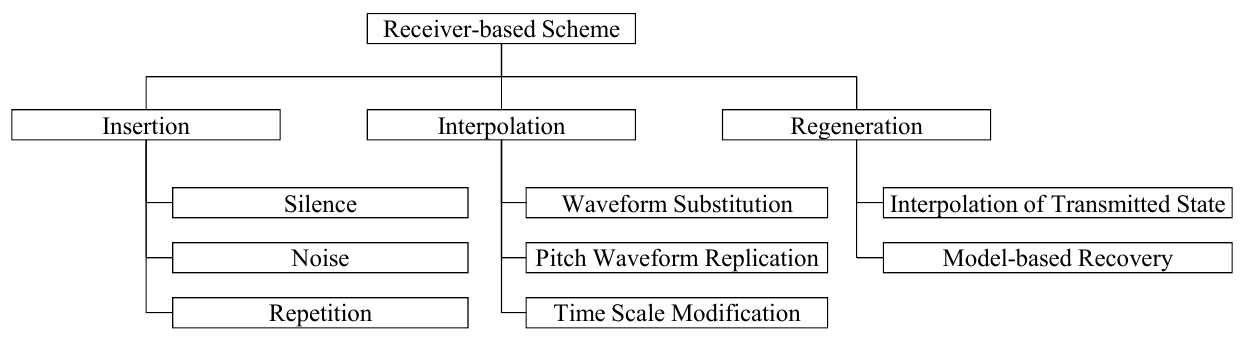
Figure 1. Classification of receiver-based error protection